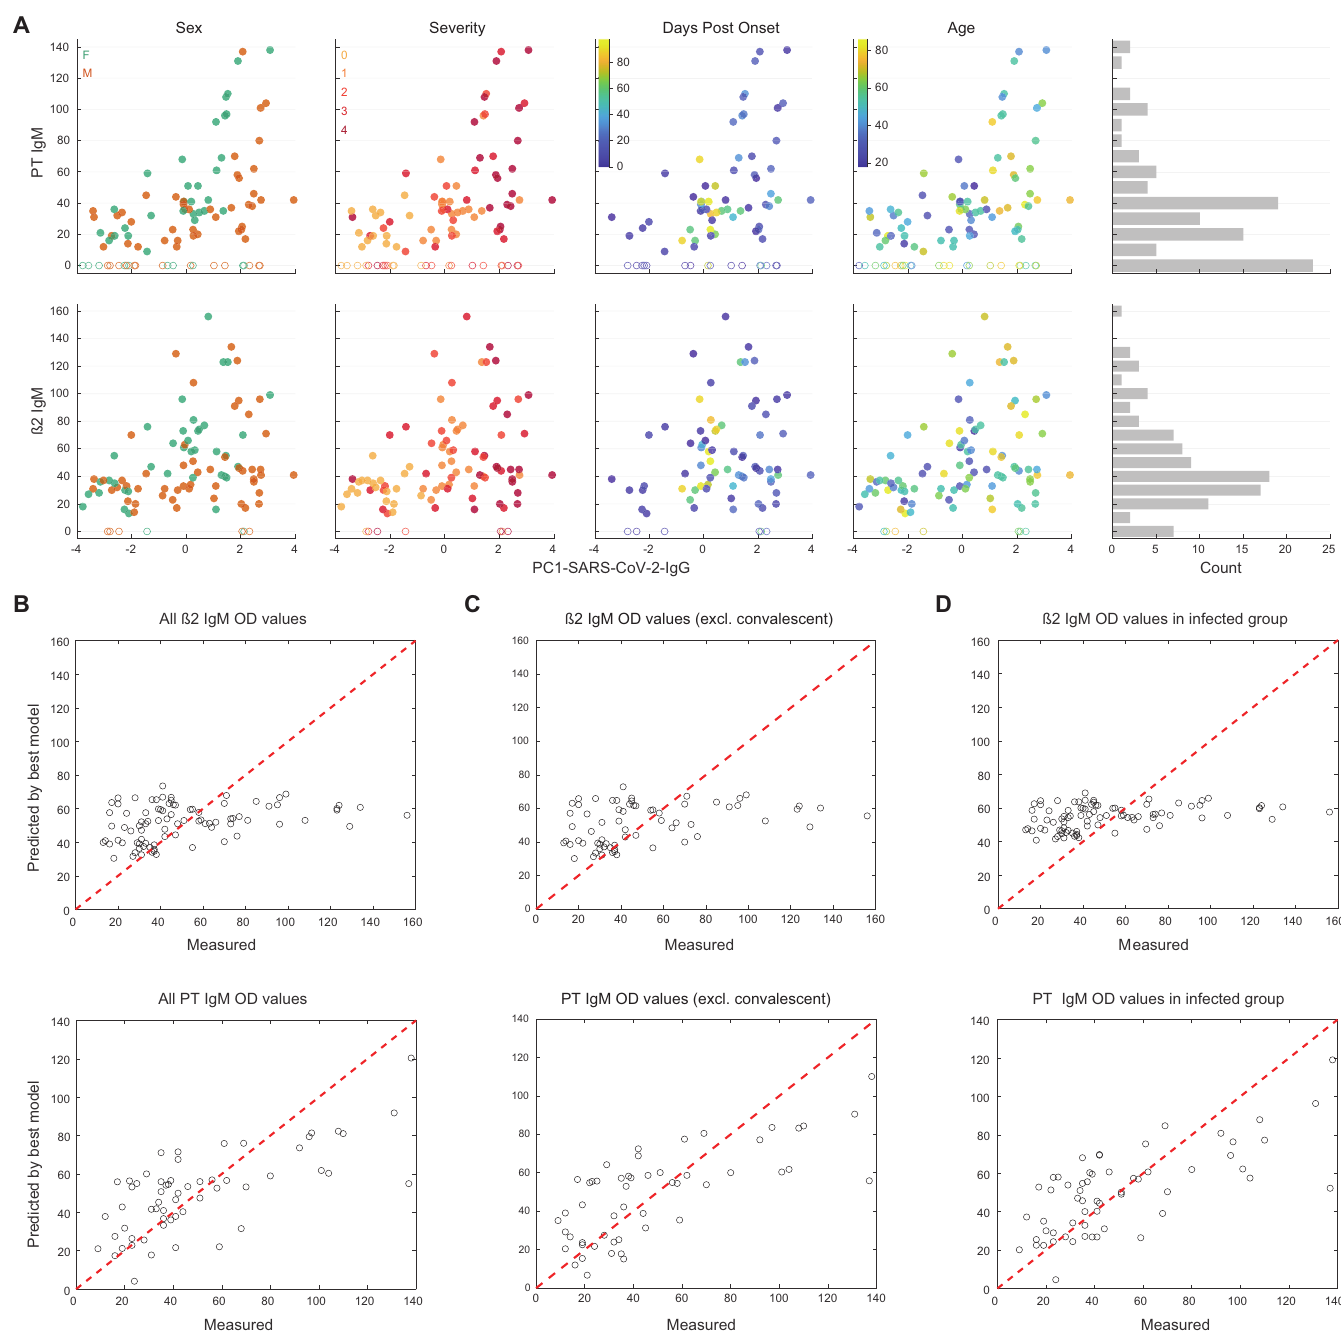
Fig 3. Exploratory multi-parametric data analysis and best-fit model for β 2 and PT IgM. A . Data exploration to inspect potential relationships between OD values for PT or β 2 IgM with PC1-SARS-CoV-2-IgG, sex (f for female, m for male), disease severity (scores 0–4), days post onset of first disease manifestation, or age (in years). A histogram of OD values was included to display the relative frequencies. After a peak at ca. OD value 40, a second peak at 0 emerges for both PT as well as for β 2 IgM. B . The fitted vs. observed β 2 and PT IgM values. While for β 2 IgM, only PC1-SARS-CoV-2-IgG is informative, PC1-SARS-CoV-2-IgG, disease severity, and sex, all contribute to the accurate prediction of OD values of PT IgM. C . Same as (B) in the absence of convalescent individuals. D . Same as (B) in the absence of non-infected